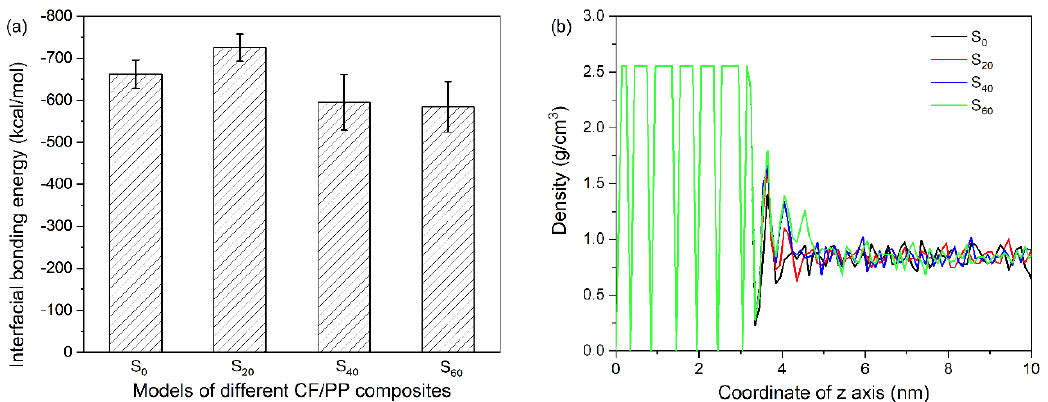
Figure 10. ( a ) Interfacial bonding energy and ( b ) density distribution along z axis of CF/PP composites. The peak position r of RDF can directly reflect the type of intermolecular